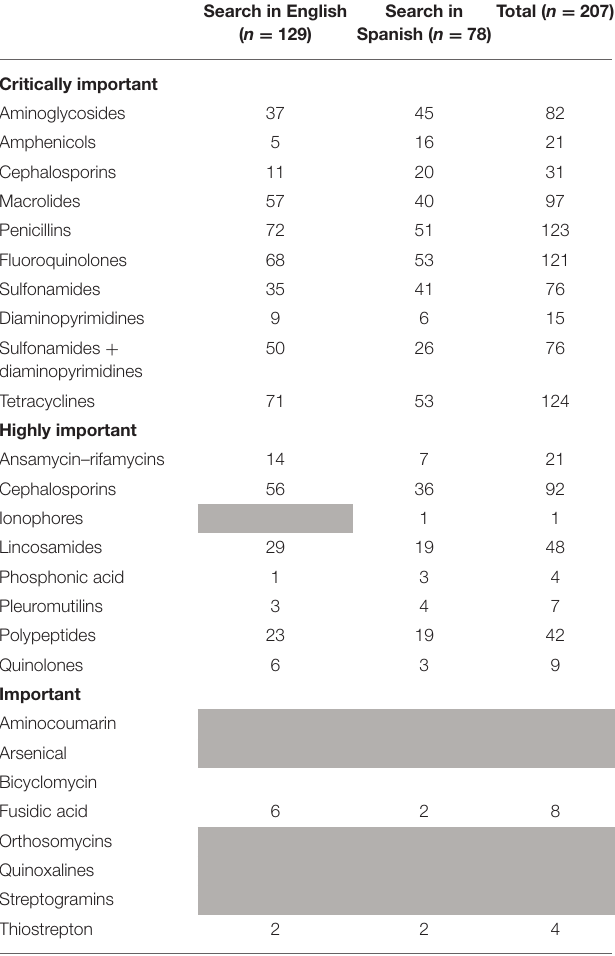
TABLE 5 | Number of websites where the families of antibiotics can be purchased, classified following the OIE list of antimicrobial agents of veterinary importance (22), in the searches in English and in